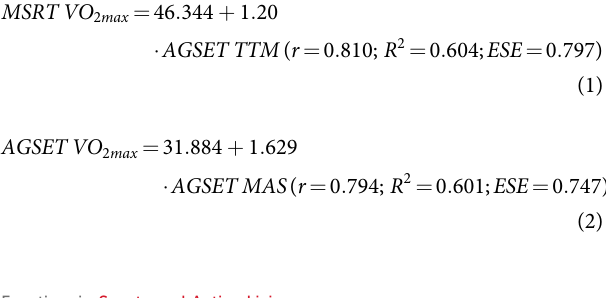
(MSRT) multistage shuttle run test; (MAS) maximal aerobic speed; (BLa) blood lactate; (HR) heart rate; (RER) respiratory exchange ratio; (TTM) total time